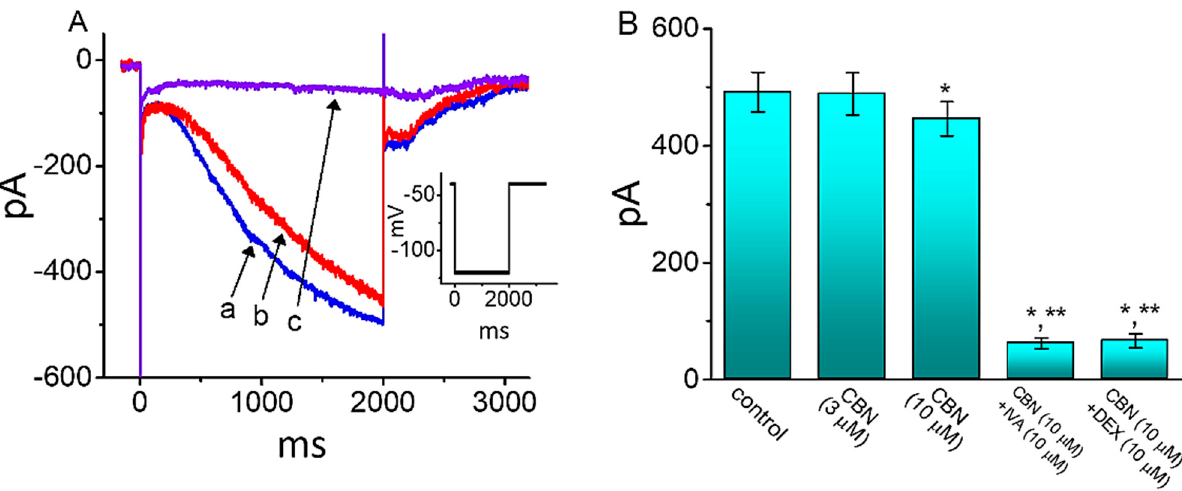
Figure 8. Effect of CBN on hyperpolarization-activated cation current ( I h ) in GH 3 cells. Cells were bathed in Ca 2+ -free, Tyrode’s solution and the pipet were backfilled with K + -containing solution. ( A ) Representative current traces obtained in the absence (a) and presence of 10 µM CBN (b) or 10 µM CBN plus 10 µM ivabradine (IVA) (c). Inset depicts the voltage protocol used. ( B ) Summary bar graph demonstrating effect of 10 µM CBN and 10 µM CBN plus 10 µM ivabradine (IVA) on the amplitude of I h (mean ± SEM; n = 7 for each bar). Current amplitude was taken at the end of 2 s hyperpolarizing pulse from − 40 to − 120 mV. * indicates significantly different from control ( p < 0.05) and ** indicates significantly different from 10 µM CBN alone group ( p < 0.05).